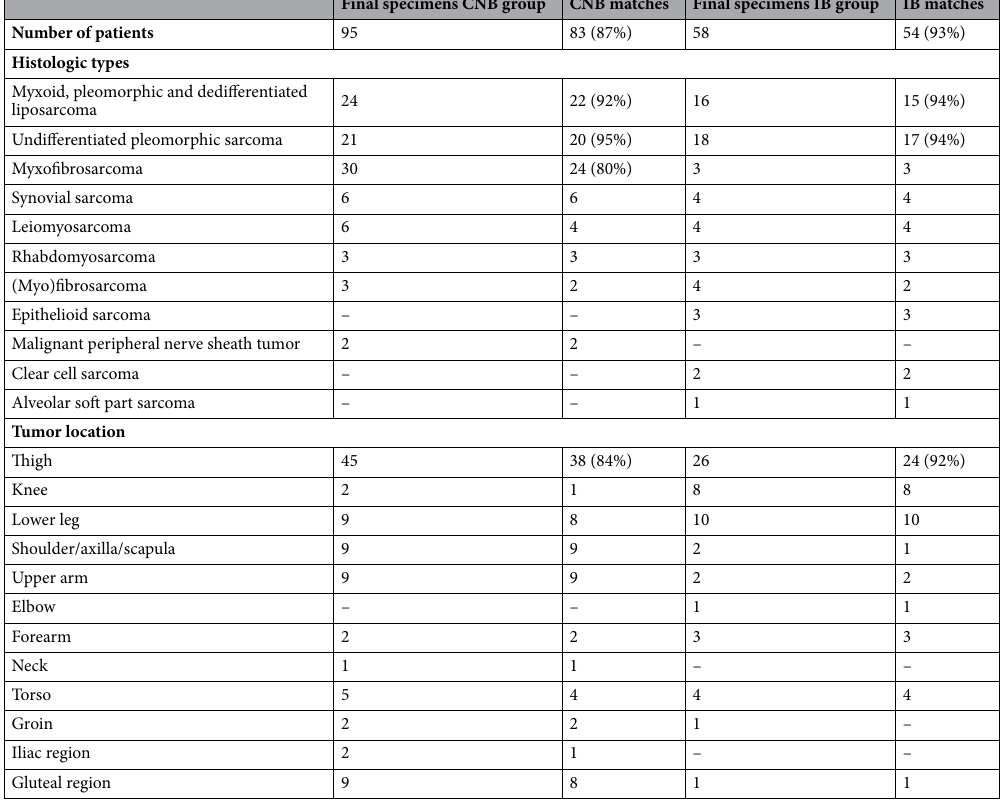
Table 1. Diagnostic accuracy in the assessment of